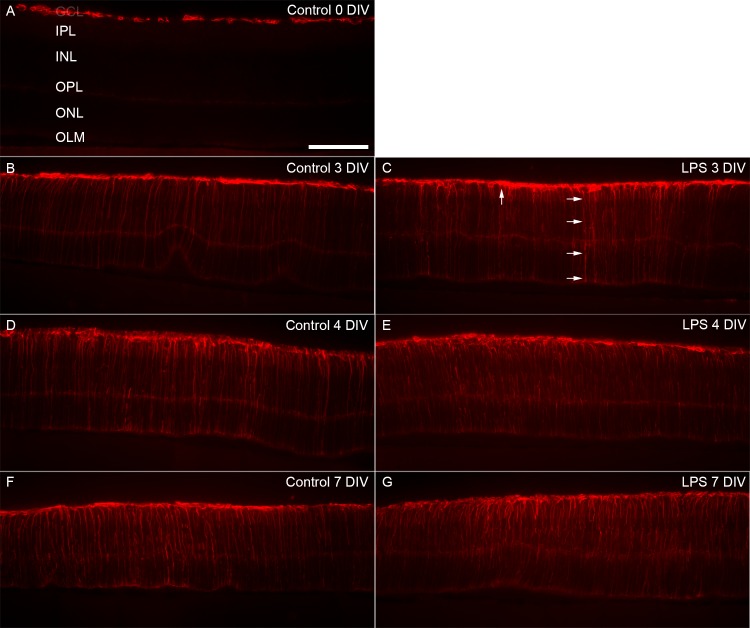
Macroglial activity detected by GFAP- staining.GFAP-immunohistochemistry was used to label the macroglial cells of the retina, i.e. astrocytes and Müller cells. At 0 DIV, GFAP-staining was primarily detected in the NFL (A). An increase in GFAP-staining was detected at 3, 4, and 7 DIV (B, D and F); with Müller cell up-regulation of GFAP, seen by labeled process. The LPS-treated retinas showed a similar GFAP-staining pattern with thin and thick GFAP-positive Müller cell processes spanning the retina from the inner to the outer part (C, arrows). GCL = ganglion cell layer, INL = inner nuclear layer, IPL = inner plexiform layer, ONL = outer nuclear layer, NFL = nerve fibre layer, OLM = outer limiting membrane. Scale bar: 200 μm.